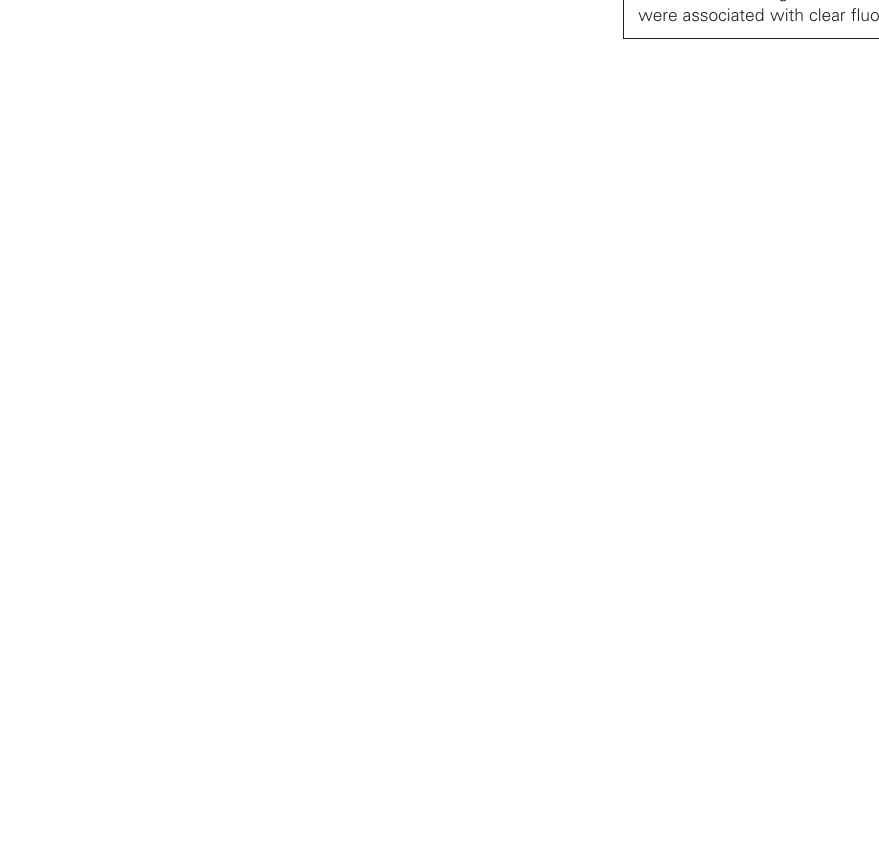
FIGURE A2 | Detection of single action potentials with calcium imaging. After multicell bolus labeling aPC slices with OGB-1, cell attached recordings were obtained from a single neuron. The LOT was stimulated at low intensities to evoke a single spike in the recorded cell. Confocal imaging (LSM510, Zeiss) was performed in the line scan mode and fluorescence changes recorded (top). Single action potentials (bottom trace) were associated with clear fluorescence increases (middle